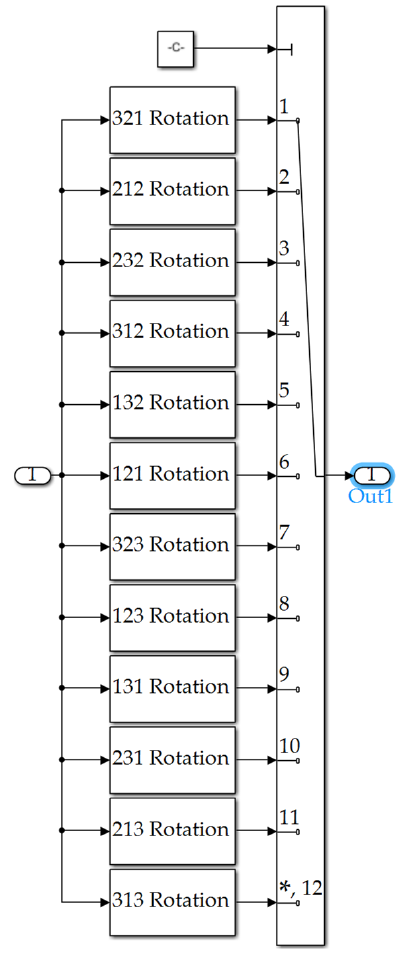
Figure A13. Euler Angle Calc subsystem depicted in Figure A1.